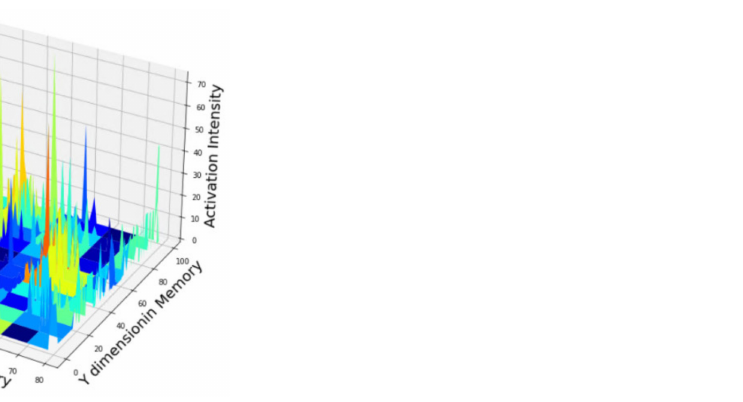
Figure 13. An example of long-term memory obtained from experiment and represented by superpo- sition SDR; The location ( x , y ) axis of activated bits and its intensity z axis are embedding information about each memory pattern.